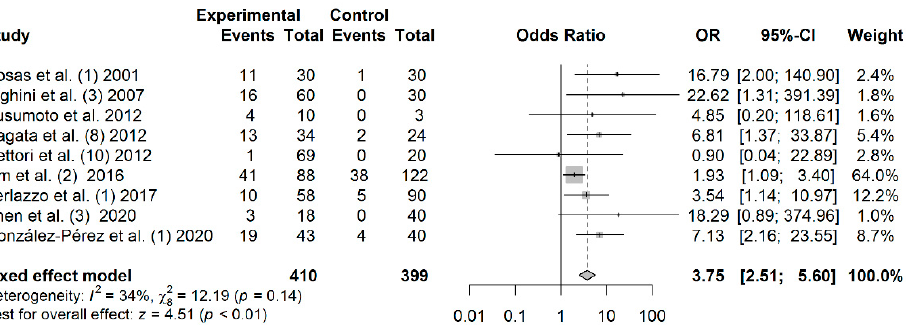
Figure 2. Forest plot for the association between p16 promoter hypermethylation and HNC risk. The squares represent the ORs for individual studies. Bars represent the 95% CIs. The center of the diamond represents the summary effect size.